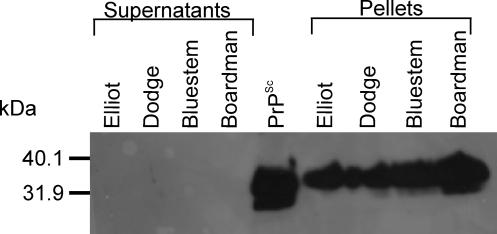
Whole Soils Bind PrPSc
Elliot, Dodge, Bluestem, and Boardman soils bound PrPSc (pelleted soils). No immunoreactivity (i.e., no unbound PrPSc) was detected in the supernatants. Immunoblot employed mAb 3F4.